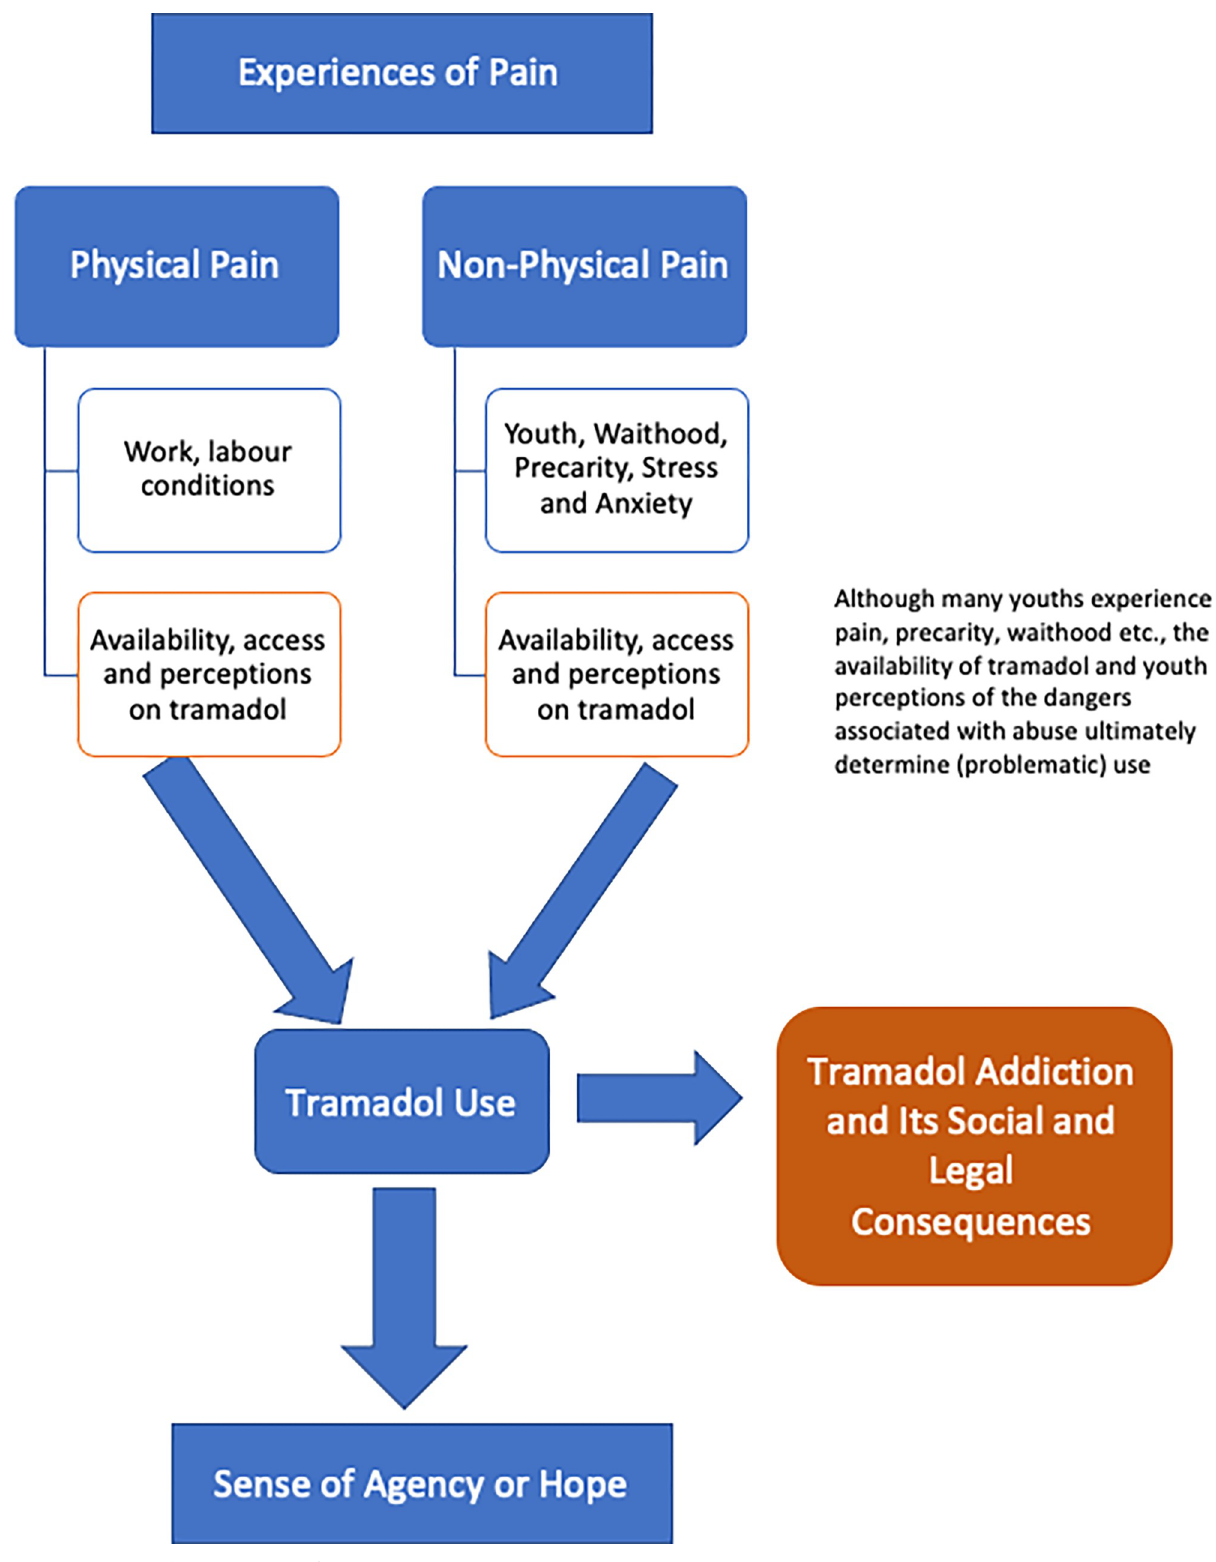
Fig 3. Two kinds of pain. Source: Author.